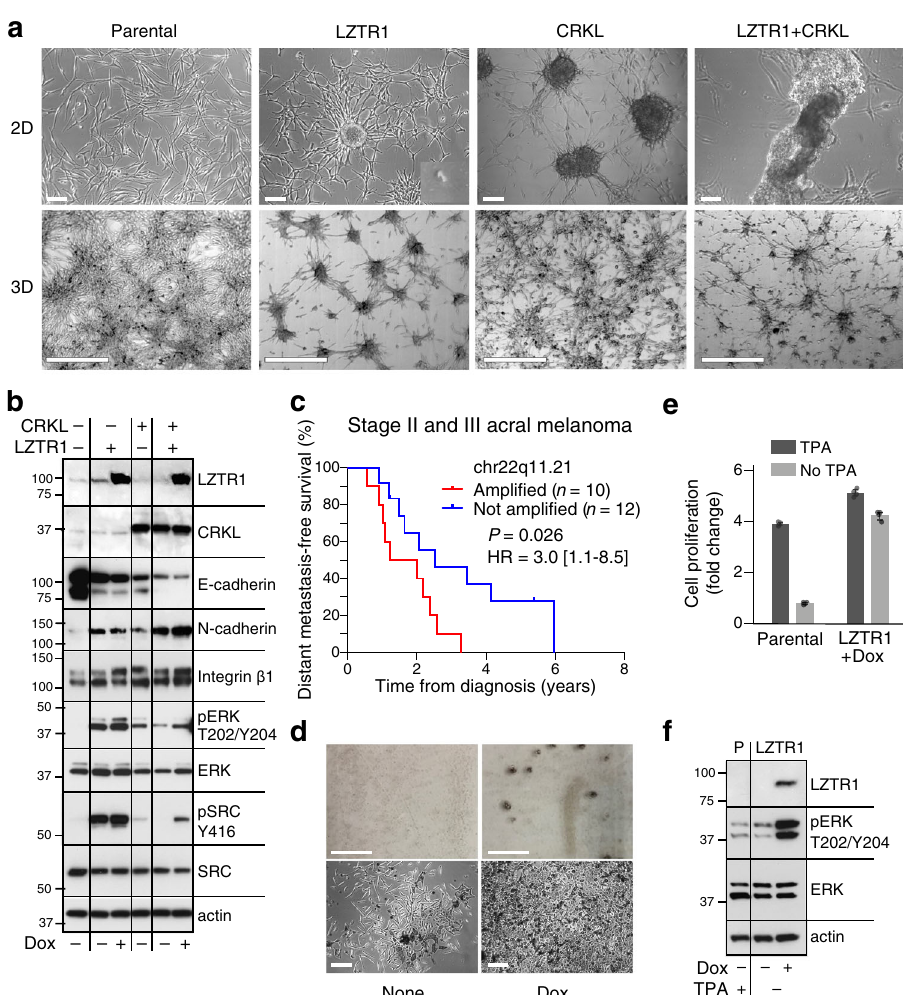
Fig. 6 Overexpression of LZTR1 and CRKL confer properties consistent with malignant cell transformation and metastasis initiation. a Morphological changes and spheroid formations in early passage normal human melanocytes (NBMEL C1220) overexpressing LZTR1 and/or CRKL. Top: Phase-contrast images of parental and infected cells in 2D culture. LZTR1 images were taken after 2 days of induction with doxycycline (200 ng/ml), CRKL after 3 days of infection with PLX304-CRKL and LZTR1 + CRKL after 6 days infection of LZTR1 melanocytes with PLX304-CRKL and 3 days stimulation with doxycycline. Non-induced LZTR1 cells grew as a monolayer, as seen for the parental non-transformed melanocytes (Parental). Scale bar = 100 µ m. Bottom: 3D cultures of melanocytes seeded in 0.5% collagen for 3 days. LZTR1 and CRKL, both alone and in combination, induced aggregation and multicellular spheroids. Scale bar = 500 µ m. b Western blot showing changes in normal human melanocytes overexpressing LZTR1, CRKL, or both (top two lanes) compared to parental ( – ). Cells were harvested after incubation in regular medium, or medium supplemented with doxycycline for 2 days when applicable (Dox, 200 ng/ml). Of note, an increase in LZTR1 produced by basal promoter activity was suf fi cient to induce constitutive MAPK and SRC activities. Actin levels show protein loading. c Differences in distant metastasis-free survival (DMFS) between acral melanoma patients strati fi ed by 22q11.21 ampli fi cation status. Patients with stage II or III disease at diagnosis with available DMFS data were shown (Yale cohort). Statistical signi fi cance was assessed by a two-sided log-rank test. HR hazard ratio. 95% HR con fi dence interval is shown in brackets. d 2D cultures of spontaneously immortalized mouse melanocytes (C57BL) forming colonies in the absence of TPA in response to LZTR1 (Dox). Dark pigmented colonies are seen without magni fi cation (top) and by phase-contrast microscopy (bottom). Scale bar = 100 µ m (top) and 200 µ m (bottom). e Proliferation of parental and LZTR1-transformed C57BL mouse melanocytes. Bar plots represent the mean fold change of n = 4 replicates with 95% con fi dence intervals indicated. f Western blots displaying LZTR1 expression and MAPK activation (pERK) in TPA-starved ( – ) mouse melanocytes in response to doxycycline ( + , 200 ng/ml), compared to parental, non-transformed cells (P). Panel a represents one of three experiments. Source data are provided as a Source Data fi consistent with HCT116 colon cancer cells, in which loss of CRKL this fi nding, while higher expression of MITF de fi nes a was found to increase E-cadherin expression and shift the cells proliferative subtype of melanoma (MITF high – AXL low ), lower expression is preferentially associated with invasion toward an epithelial phenotype 69 . Importantly, LZTR1 and CRKL, both alone and in combination, induced high levels of (MITF low – AXL high ) 73 . Based on these fi ndings, we hypothesized that co-ampli fi cation constitutively active ERK and SRC relative to parental cells of LZTR1 and CRKL might lead to increased rates of distant (Fig. 6b, pERK and pSRC), functions that support viability and recurrence. Given that 22q11.21 ampli fi cation is preferentially a proliferation. We also identi fi ed the downregulation of MITF in late-arising event in acral melanoma (Fig. 2c, left), we tested this cells overexpressing CRKL as the possible cause for growth rate hypothesis by examining acral melanoma patients diagnosed with attenuation (Fig. 6b and Supplementary Fig. 9a). Consistent with